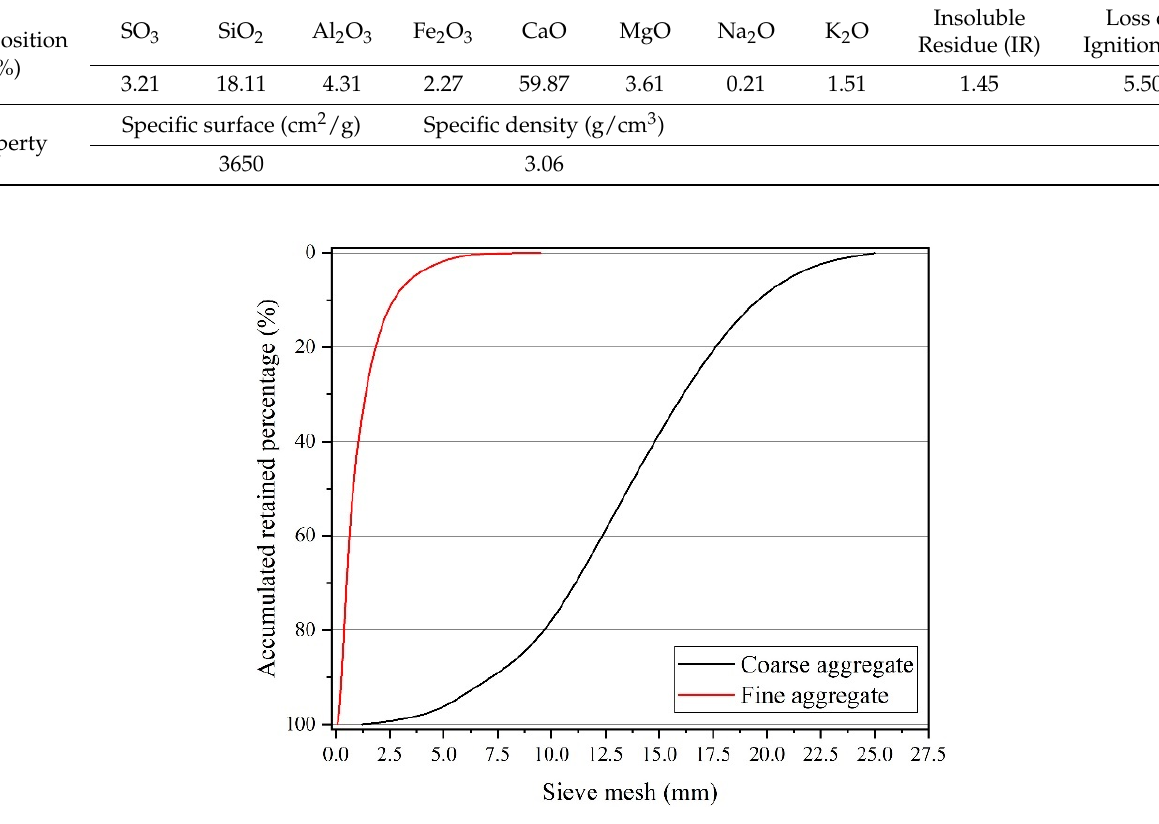
Figure 3. Granulometric curves for coarse and fine aggregates.